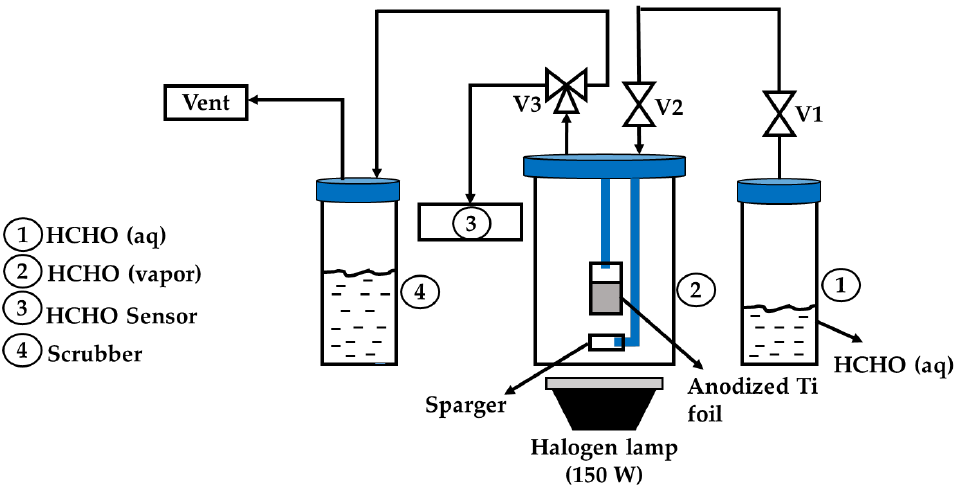
Figure 3. Photoreactor system for formaldehyde (HCHO) photodegradation.